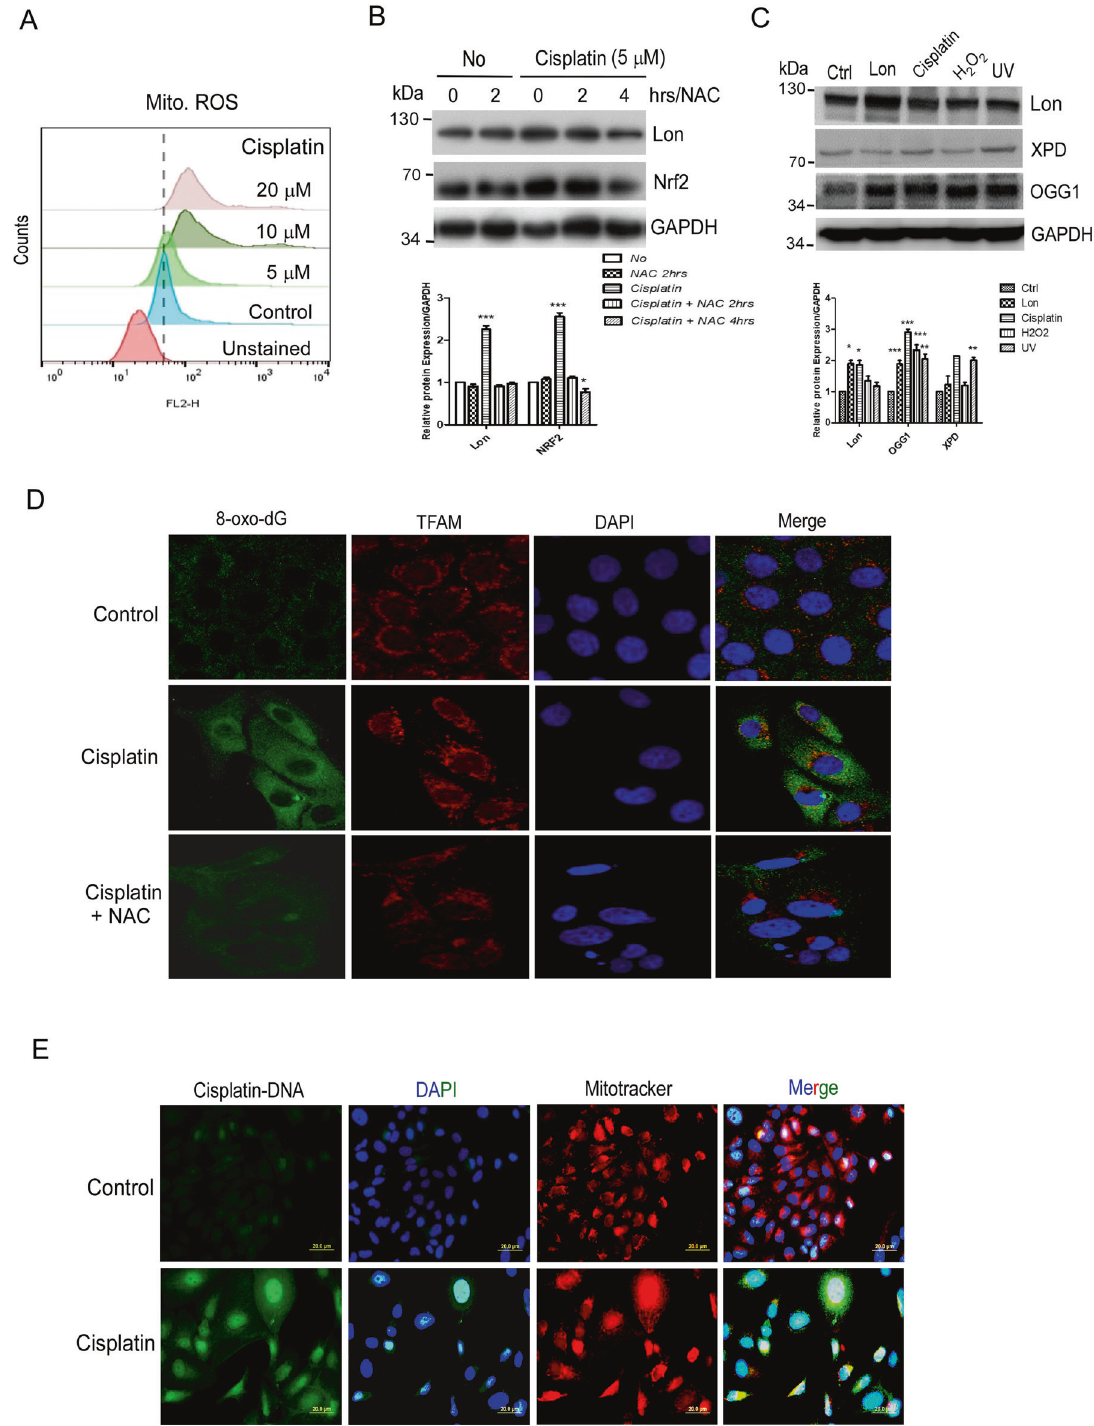
Fig. 2 Cisplatin treatment causes ROS-dependent mitochondria DNA damage. A Cisplatin treatment triggers mitochondrial ROS production. OEC-M1 cells were treated with different concentrations of cisplatin and mitochondrial ROS levels were detected using Mitosox dye. B Cisplatin treatment induces Lon expression in a ROS-dependent manner. OEC-M1 cells were treated with or without NAC (5 mM), a ROS scavenger, for indicated time points followed by with or without treatment with cisplatin for 48 h. Cell lysates were collected and Western blot was performed by using indicated antibodies. C Cisplatin and Lon overexpression causes oxidative DNA damage OEC-M1 cells were transfected with vector or Lon plasmid or treated with cisplatin. Western blot was performed using indicated antibodies. H 2 O 2 and UV treatment acts as positive controls. Western blot was performed using indicated antibodies. D and E Cisplatin binds to mitochondrial DNA (mtDNA) and causes oxidative damage in mtDNA. D OEC-M1 cells were treated with or without NAC 5 mM for 4 h followed by incubation with or without cisplatin for 48 h and immuno fl uorescence staining was performed using 8-oxo-dG (green), TFAM (red) and merged images with DAPI (blue). E OEC-M1 cells were treated with or without cisplatin (5 µM) for 48 h and immuno fl uorescence staining was performed using anti- Cisplatin-DNA adducts antibody (green), Mitotracker (red) and merged images with DAPI (blue). Scale bar, 20 μ m. Cell Death and Disease (2022)